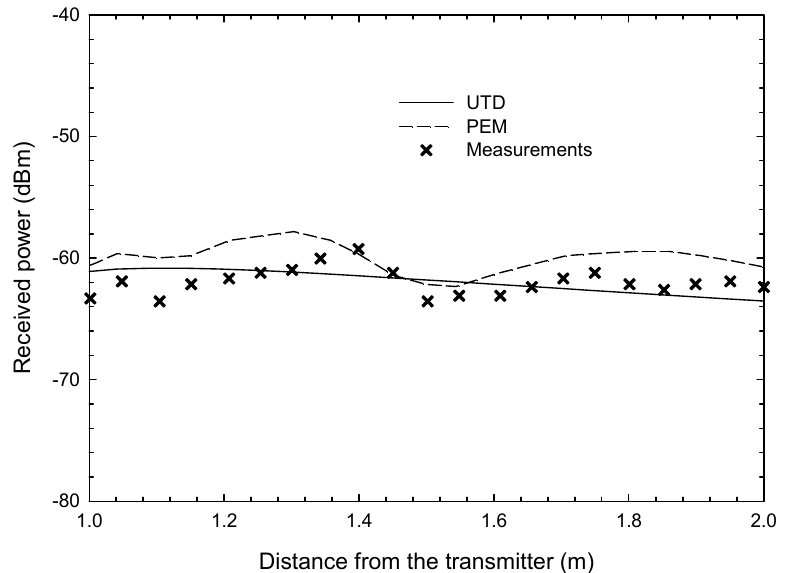
Figure 31. Comparison between the theoretical GO/UTD results for the second NLOS scenario and the measurements presented in [7].